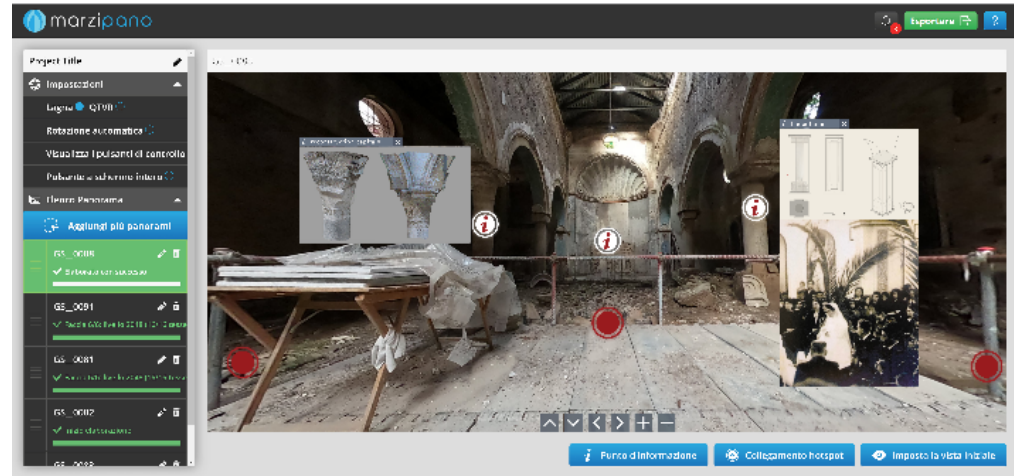
Figure 16. Tour virtual design with Marzipano.